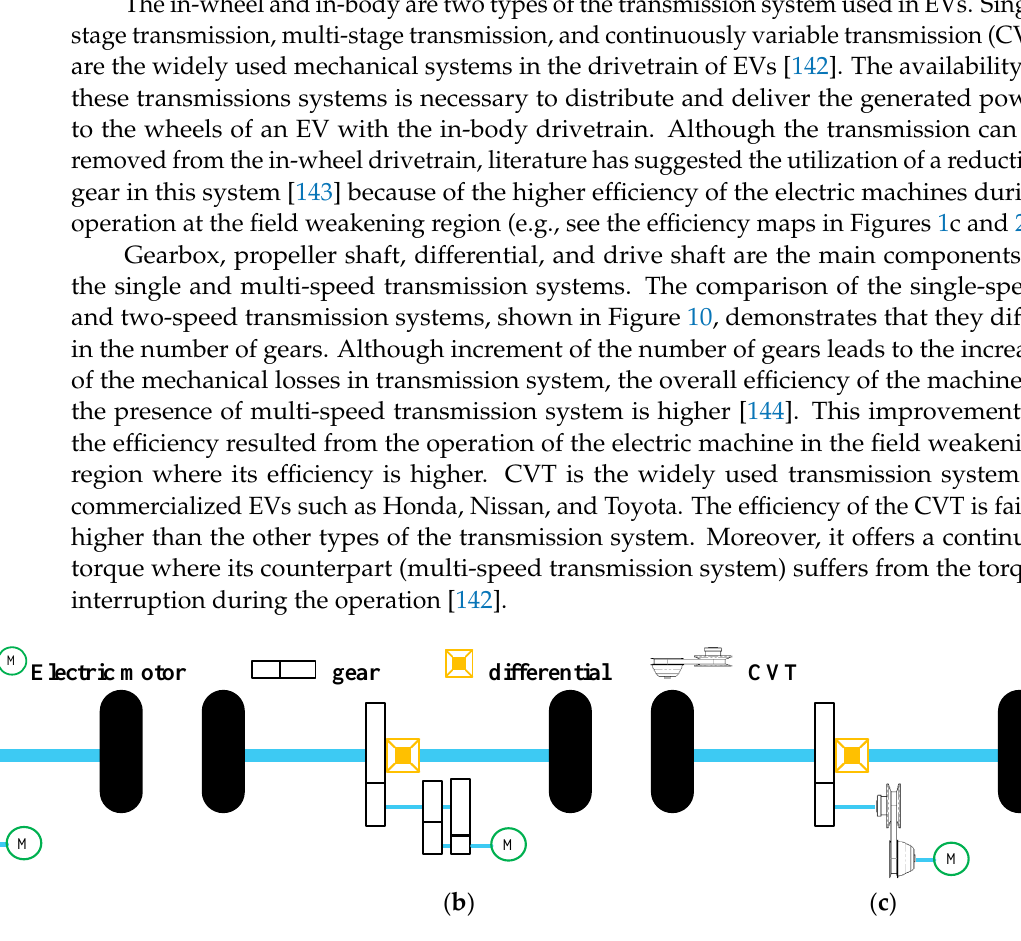
Figure 10. The graphical illustration of three widely used transmission systems in EVs [142]. ( a ) single-speed transmission. ( b ) two-speed transmission. ( c ) CVT transmission.